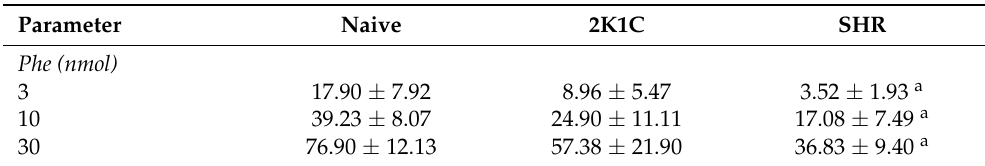
Table 4. Mesenteric vascular reactivity of the different experimental groups at the end of 6 weeks of treatment with the high-fat